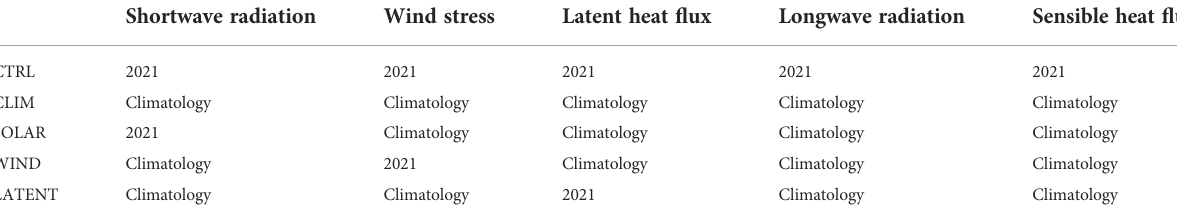
TABLE 1 Forcing conditions for sensitivity tests of one-dimensional